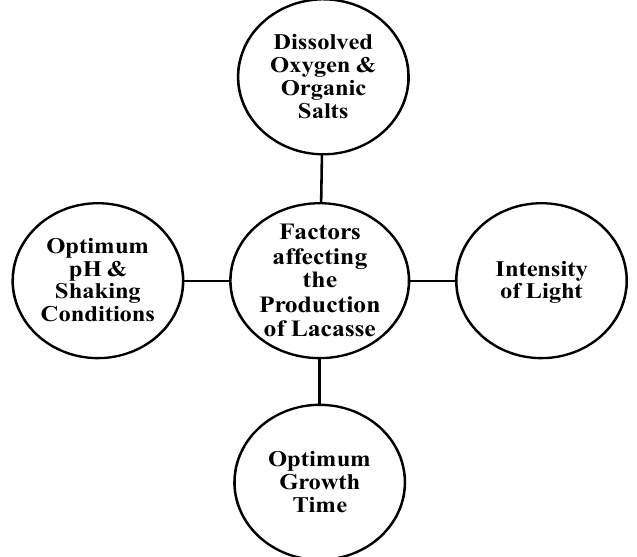
Figure 2. Factors affecting the production of Laccase.